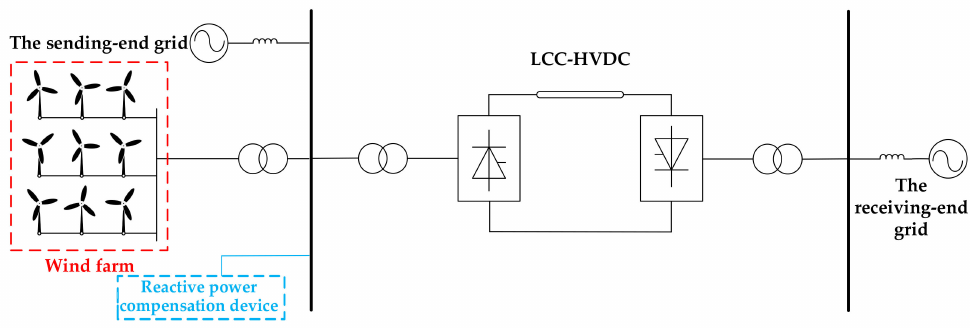
Figure 1. The topology of the wind power transmission.